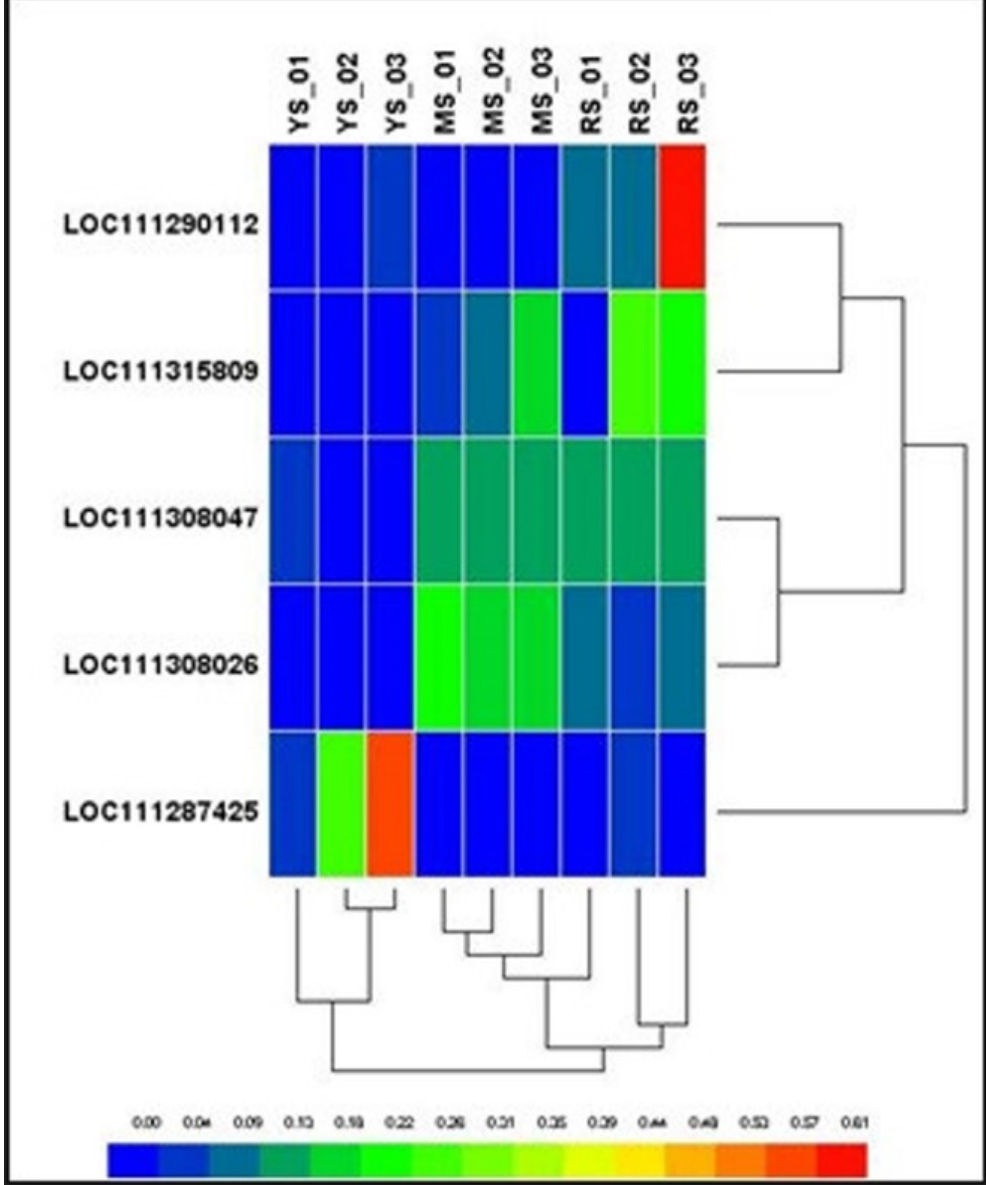
Figure 8 − Heatmap showing the expression of MGL (Methionine gamma lyases) gene isoforms in three different growth stages of durian fruit pulp. YS represents for the young stage; MS represents the mature stage, and RS represents ripening stage. The FPKM value and Pearson’s distance are used as the